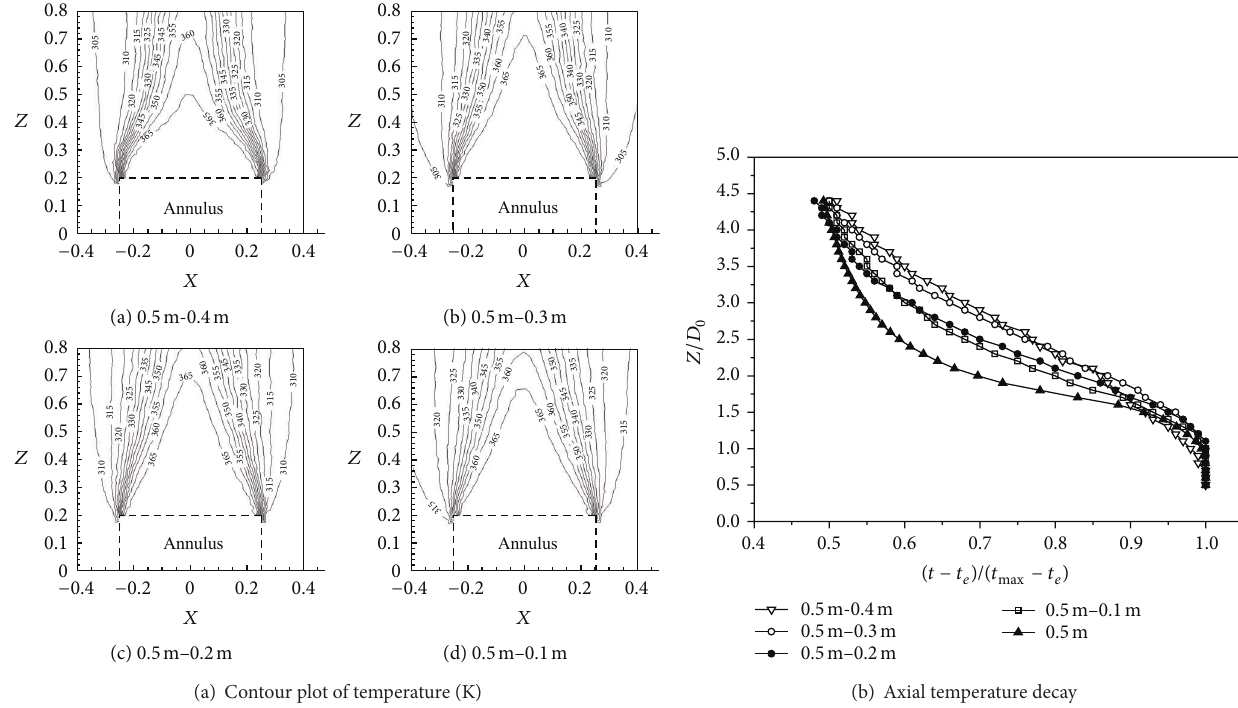
Figure 5: Axial temperature decay of different annular jet widths.